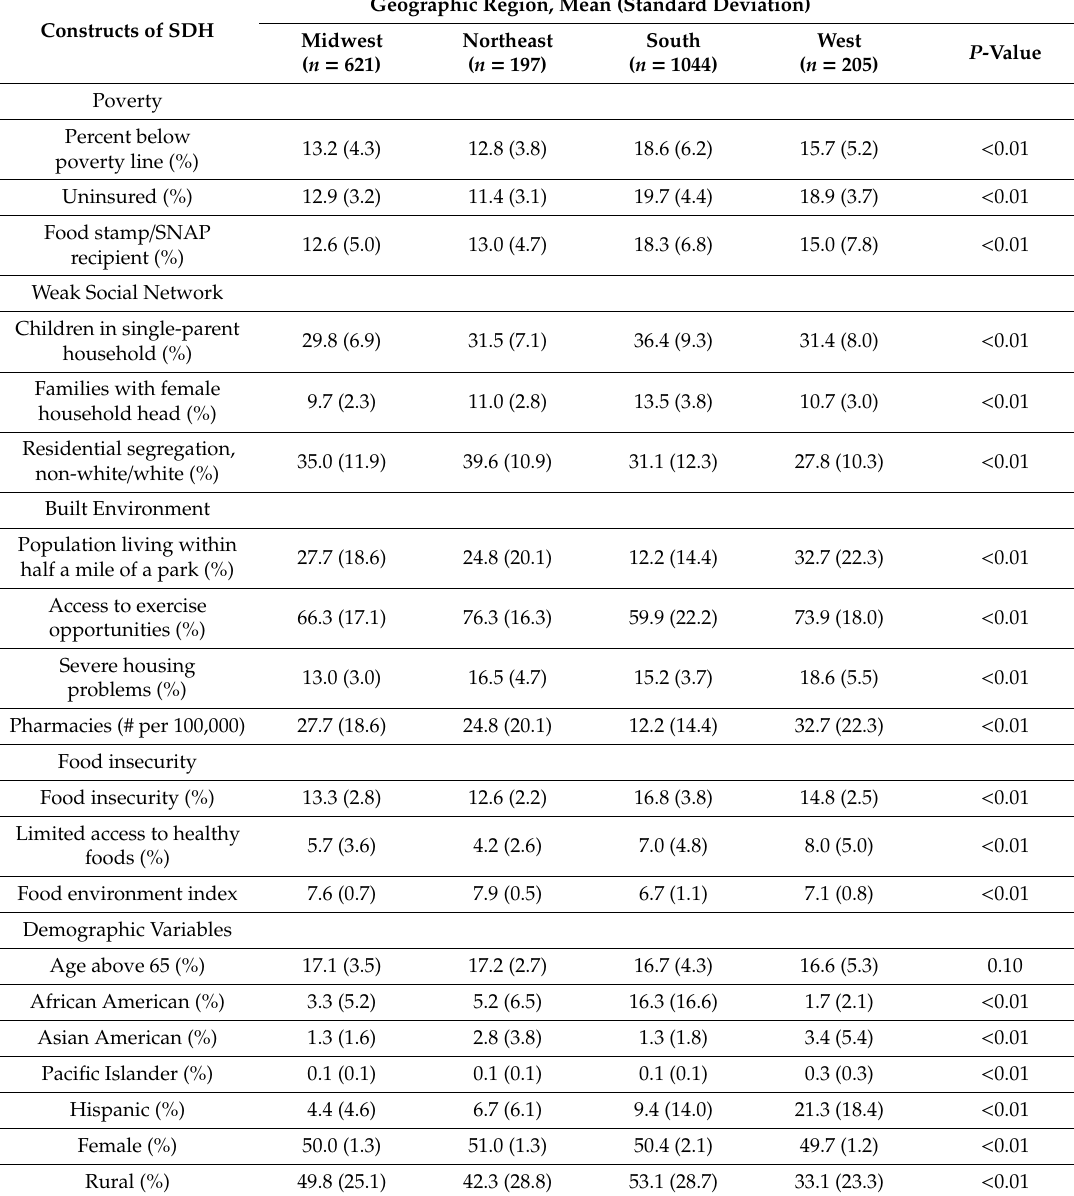
Table 1. Distribution of social determinants of health (SDH) indicators across geographical regions among counties in the U.S.,